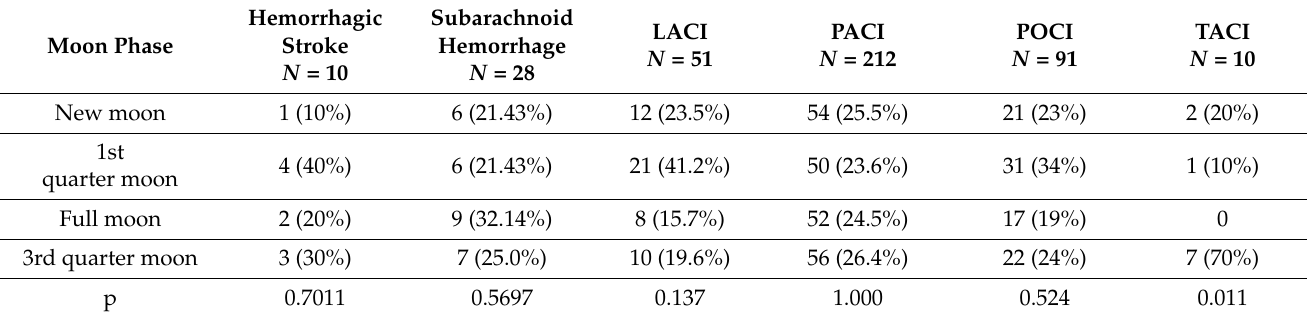
Table 6. Types of stroke in each moon